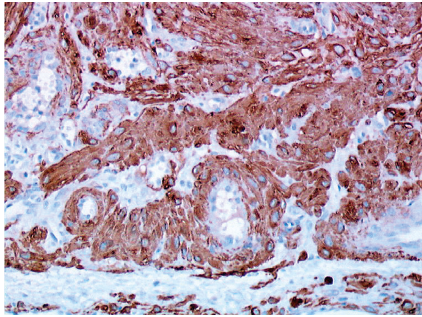
Figure 4: By immunohistochemistry, tumor cells express caldes- mon (immunoperoxidase revealed with aminoethylcarbazole) (original magnification: ×